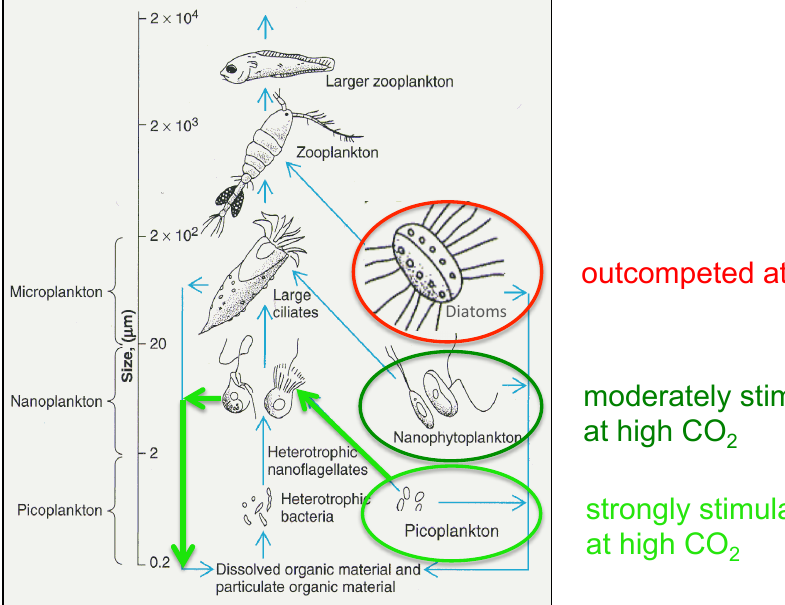
Fig. 3. Sketch of plankton groups and size classes represented in the mesocosms; blue arrows indicate trophic linkages; green circles and arrows indicate groups and processes stimulated by elevated CO 2 , red circle indicates diatoms being negatively impacted through CO 2 - stimulated effects in the smaller size classes (graph copyright 2001 by Benjamin